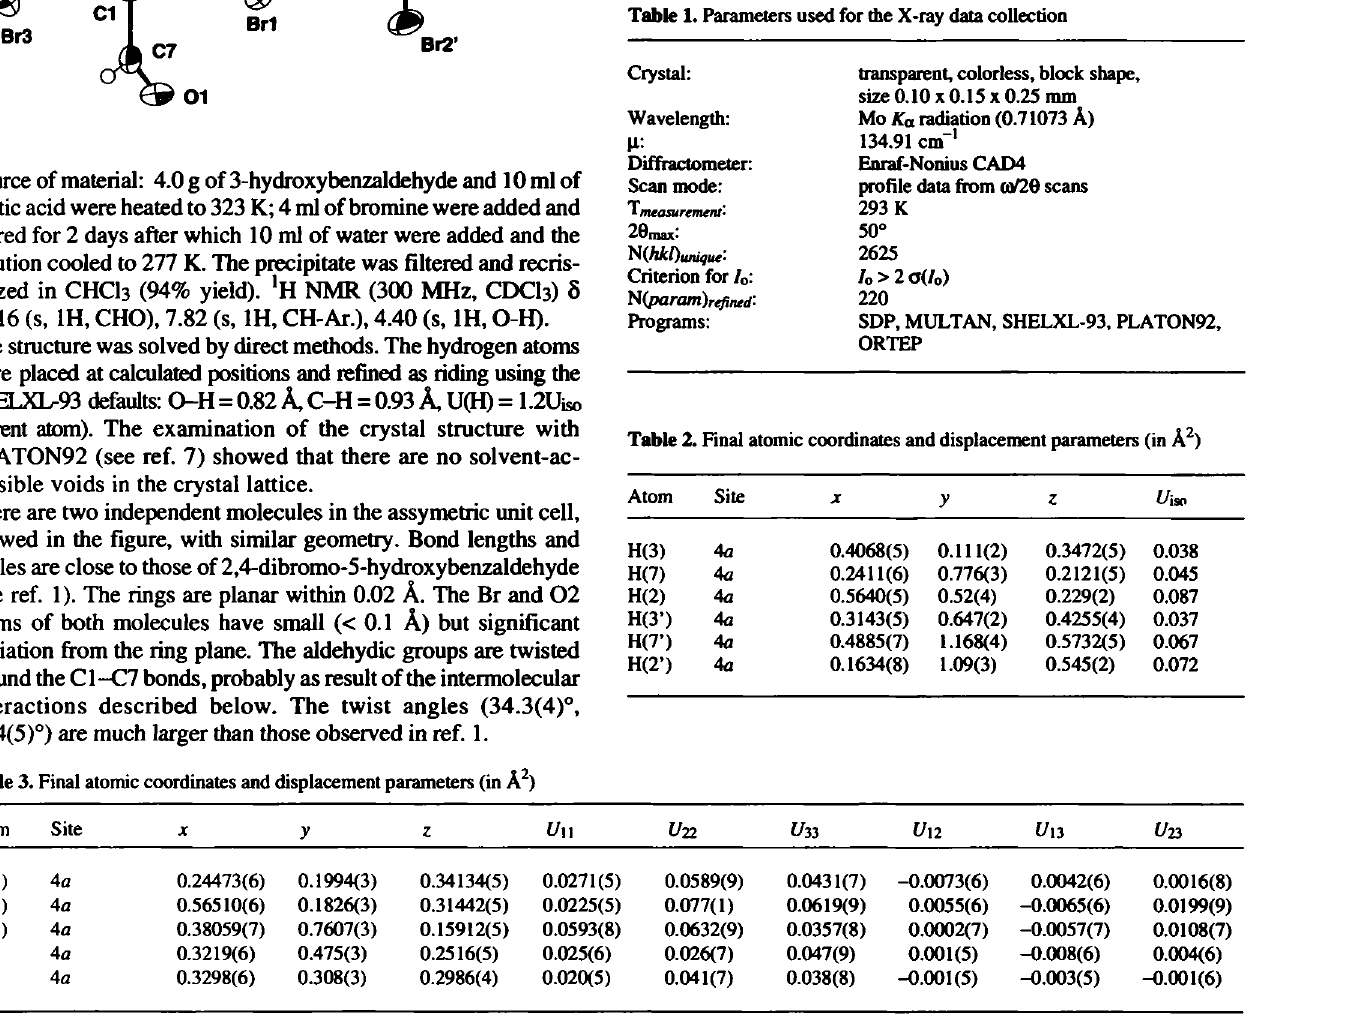
Table 1. Parameters used for the X-ray data collection